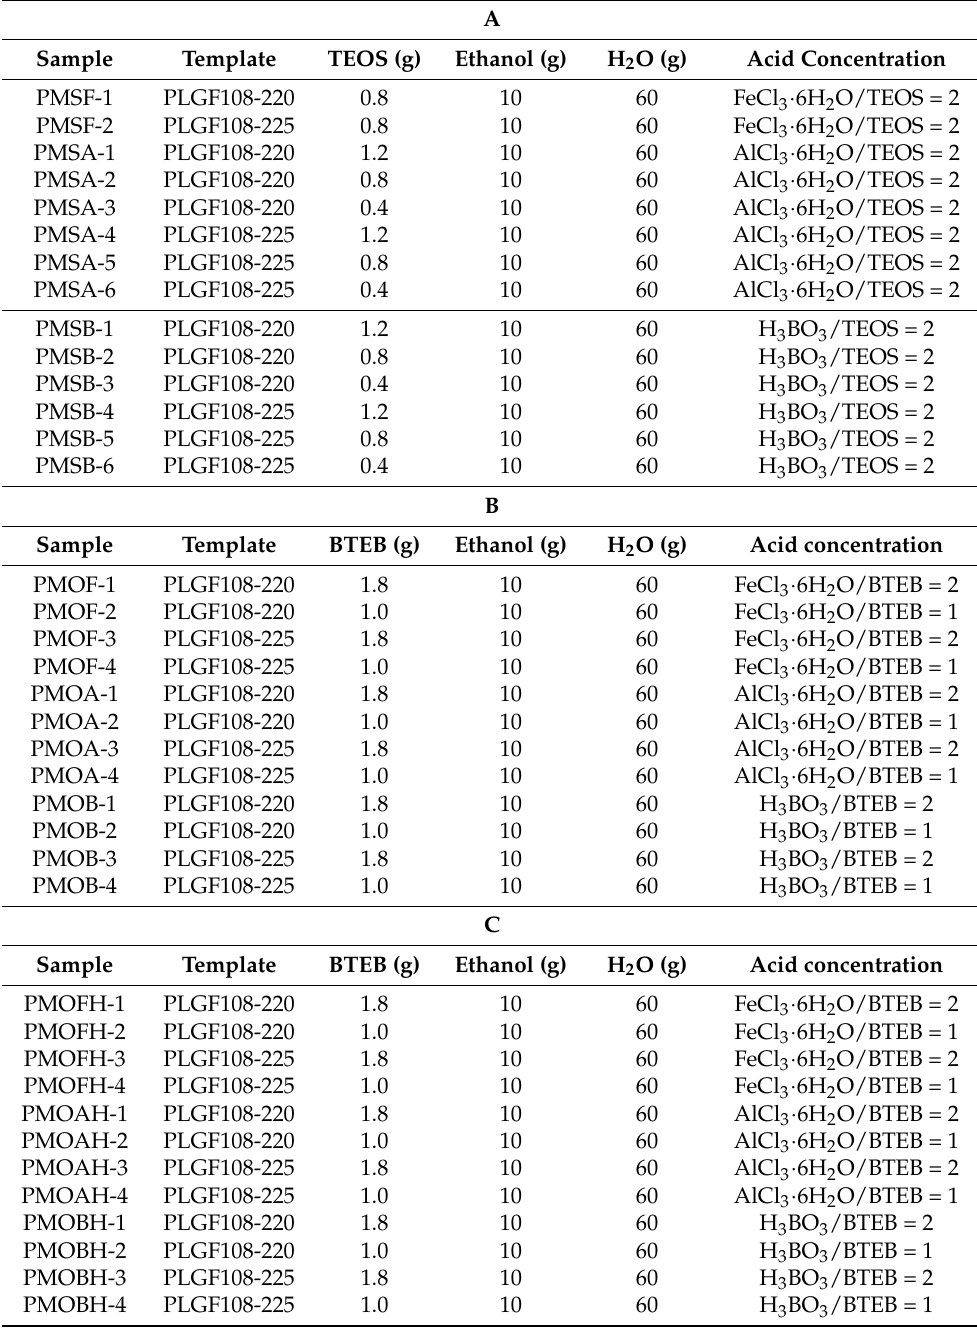
Table 2. Nomenclature and experimental parameters of mesoporous silica/organosilicas samples a